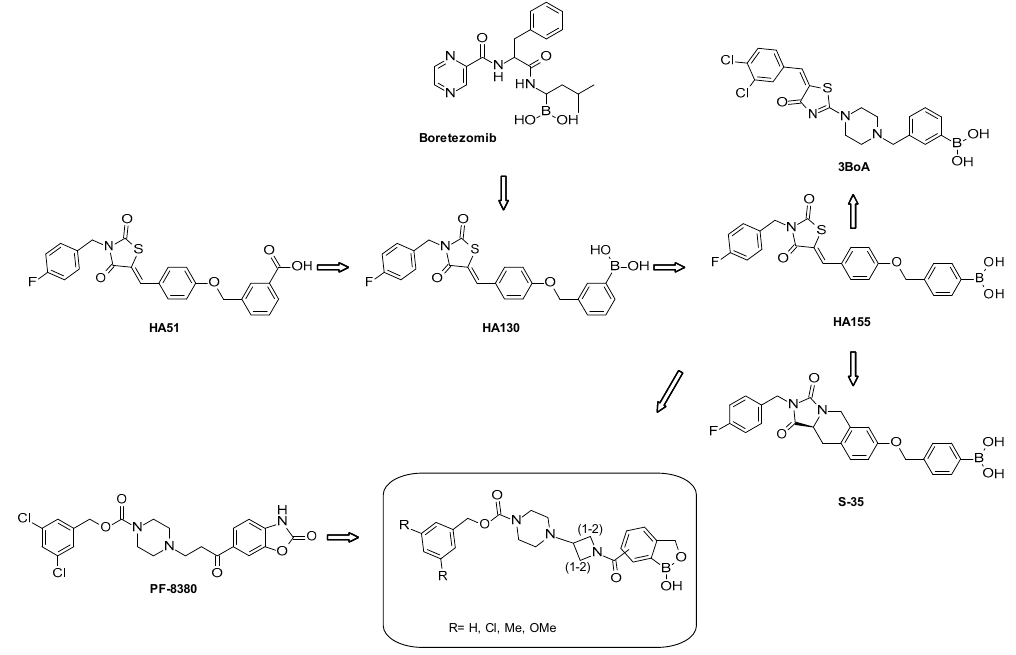
Figure 2. Design and development of small molecule ATX inhibitors.